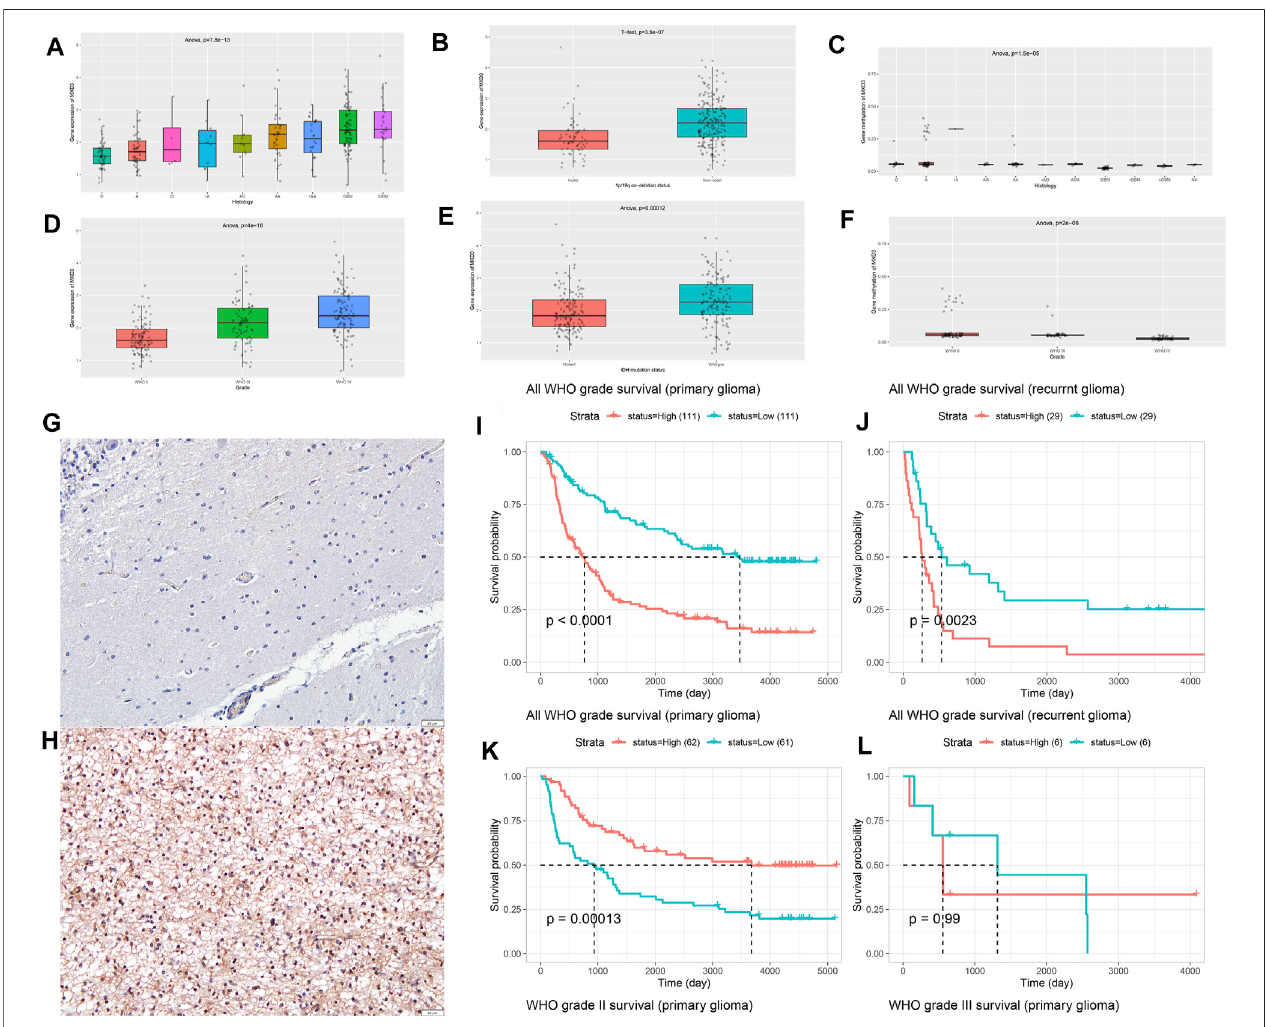
FIGURE 14 | Differential expression of MXD3 in tissues (A) and WHO subtypes (D) of glioma. Differential expression of MXD3 in 1p/19q codeletion (B) and IDH mutation status (E) . Differential expression of MXD3 promoter methylation in tissues (C) and WHO subtypes (F) of glioma. Representative images of MXD3 immunohistochemistry in glioma. The image shows a 16x magni fi cation. Scale bars (cid:1) 50 μ m (normal (G) , glioma (H) . OS of MXD3 expression in primary glioma (I) and recurrent glioma (J) . OS of MXD3 promoter methylation status in primary glioma (K) and recurrent glioma (L) .